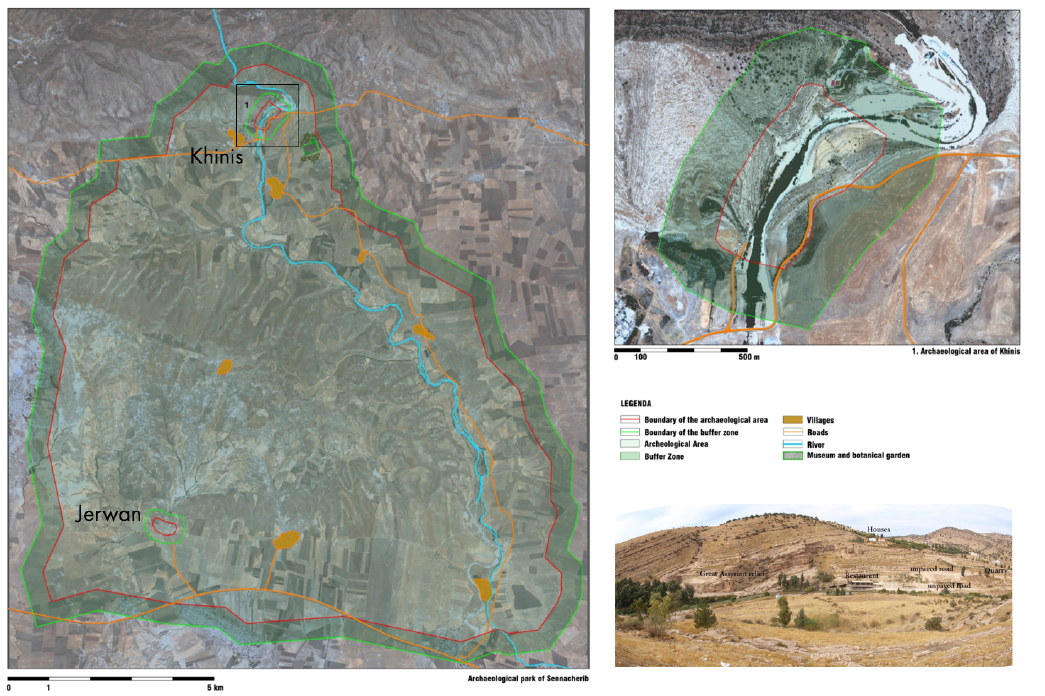
Figure 2. On the left: the borders of the entire Archaeological Park with the core (in red) buffer zones (in green) and with highlighted Khinis and Jerwan areas. The upper right side represents the borders of the Khinis area, while, in the lower right side, a picture of the area is reported.